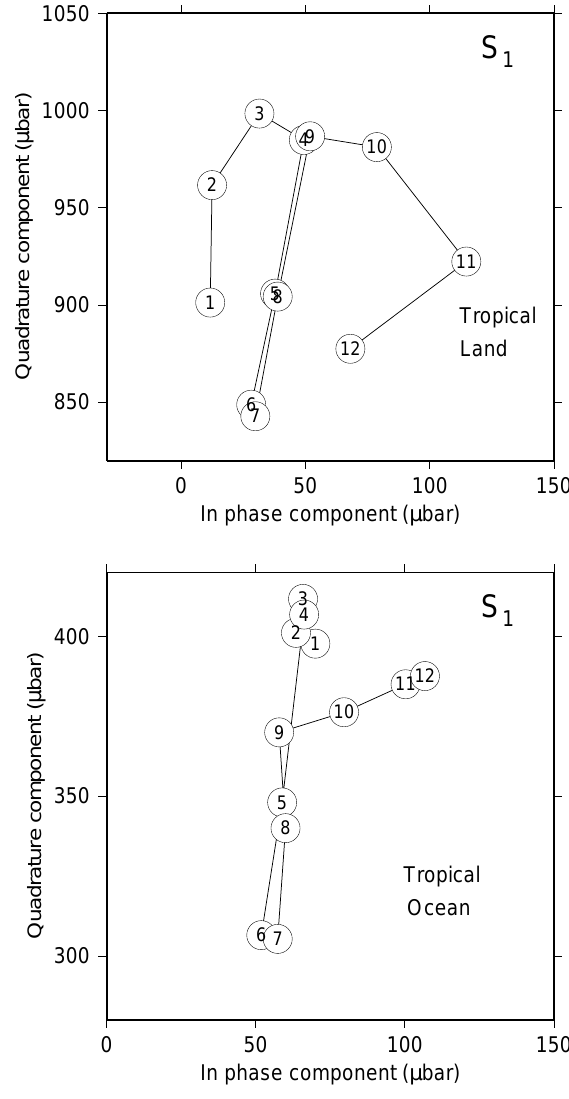
Fig. 12. As in Fig. 11 but for S 1 (p) , and separated into tropical ocean and land